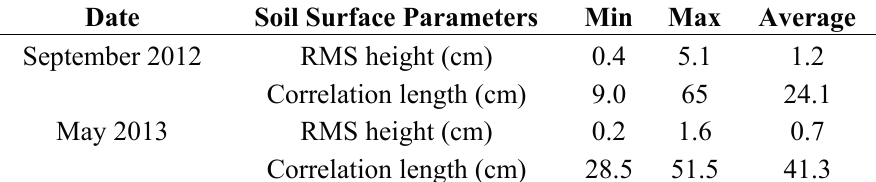
Table 2. Roughness measurements in study areas.